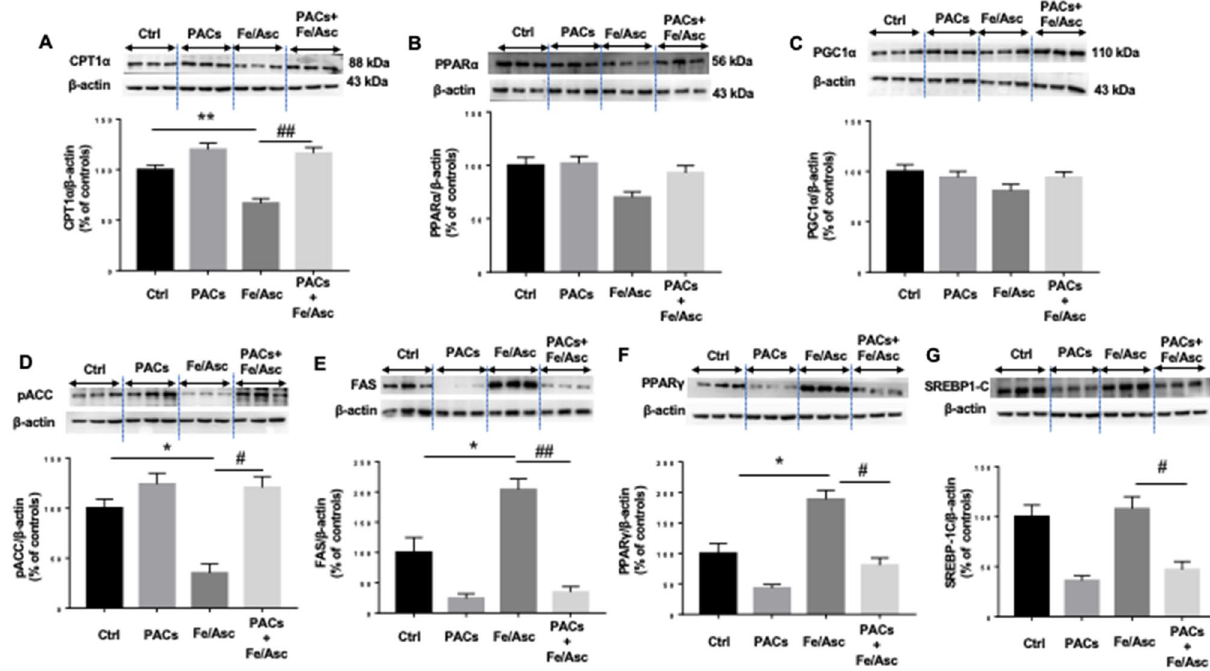
Figure 4. Effects of PACs on FA β-oxidation and lipogenesis in Caco-2/15 cells. Proanthocyanidins (PACs, 250 µg/mL), were added to the apical cell compartment for 24 h prior to treatment with Fe/Asc (200 µM/2 mM) for 6 h at 37 °C. The protein expression of specific markers of FA β-oxidation: (( A ) CPT1α, ( B ) PPARα and ( C ) PGC1α as well as of lipogenesis: ( D ) ACC phosphorylation, ( E ) FAS, ( F ) PPARγ and ( G ) SREBP1) was assessed by Western-blot. Results represent the means ± SEM of 3 independent experiments, each in triplicate. A representative Western blot is shown, illustrating an experiment in triplicate on the same gel and at with same exposure. *P < 0.05; **P < 0.01 vs untreated cells (ctrl). # P < 0.05; ## P < 0.01 vs Fe/Asc treated cells. CPT1α carnitine palmitoyl transferase I alpha, PPAR peroxisome proliferator-activated receptor, PGC1α peroxisome proliferator-activated receptor gamma coactivator 1-alpha, ACC Acetyl-CoA carboxylase, FAS Fatty acid synthase, SREBP1-c Sterol regulatory element-binding protein.